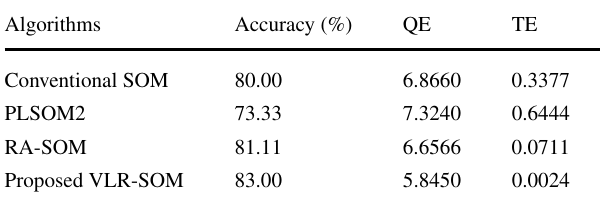
Table 7 Comparative analysis of conventional SOM, PLSOM2, RA- SOM, and proposed VLR-SOM algorithms for handwritten